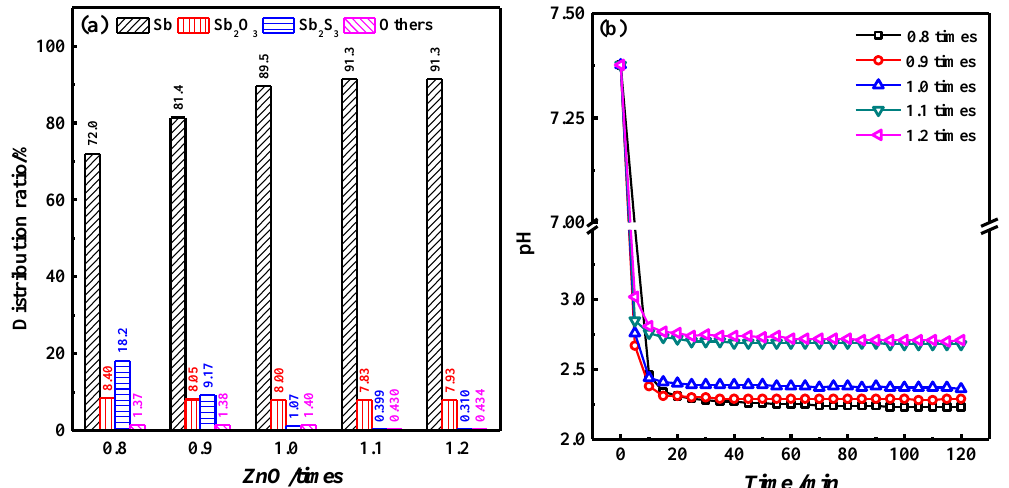
Figure 7. ( a ) Phase distribution ratio of Sb in the roasted products; and ( b ) pH value of KMnO 4 solution at different contents of ZnO.